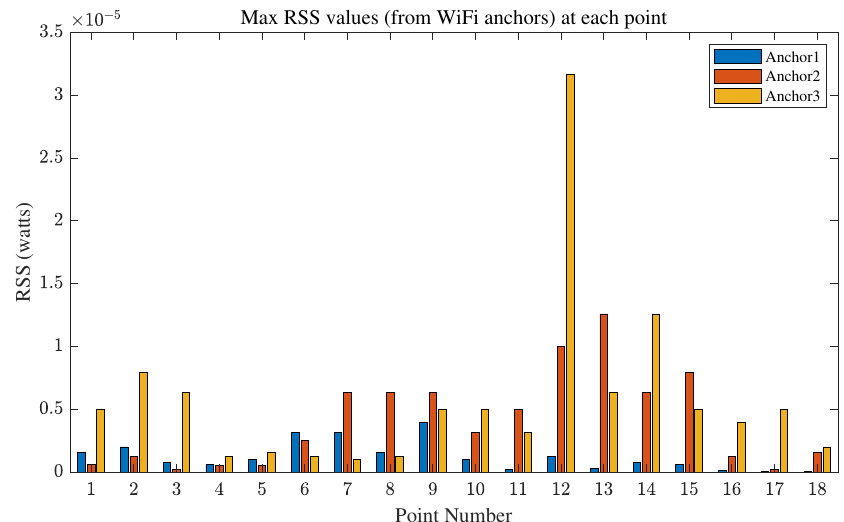
Figure 18. Maximum RSS values in one epoch at each reference point for signals received from three WiFi anchors.